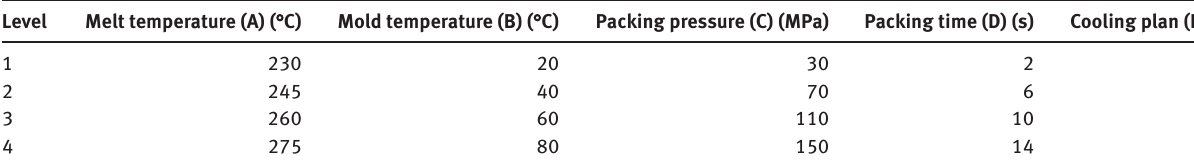
Table 5: Orthogonal experimental